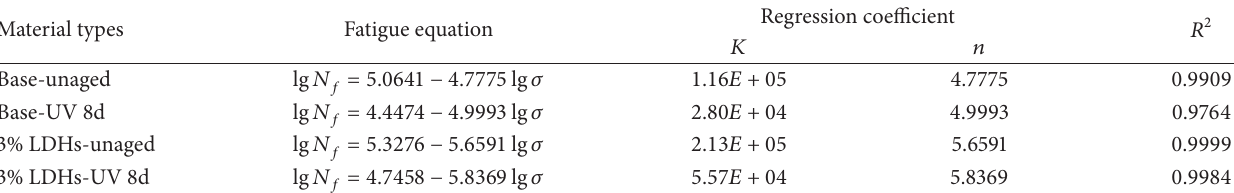
Table 6: Regression coefficients of fatigue equation at 5 ∘